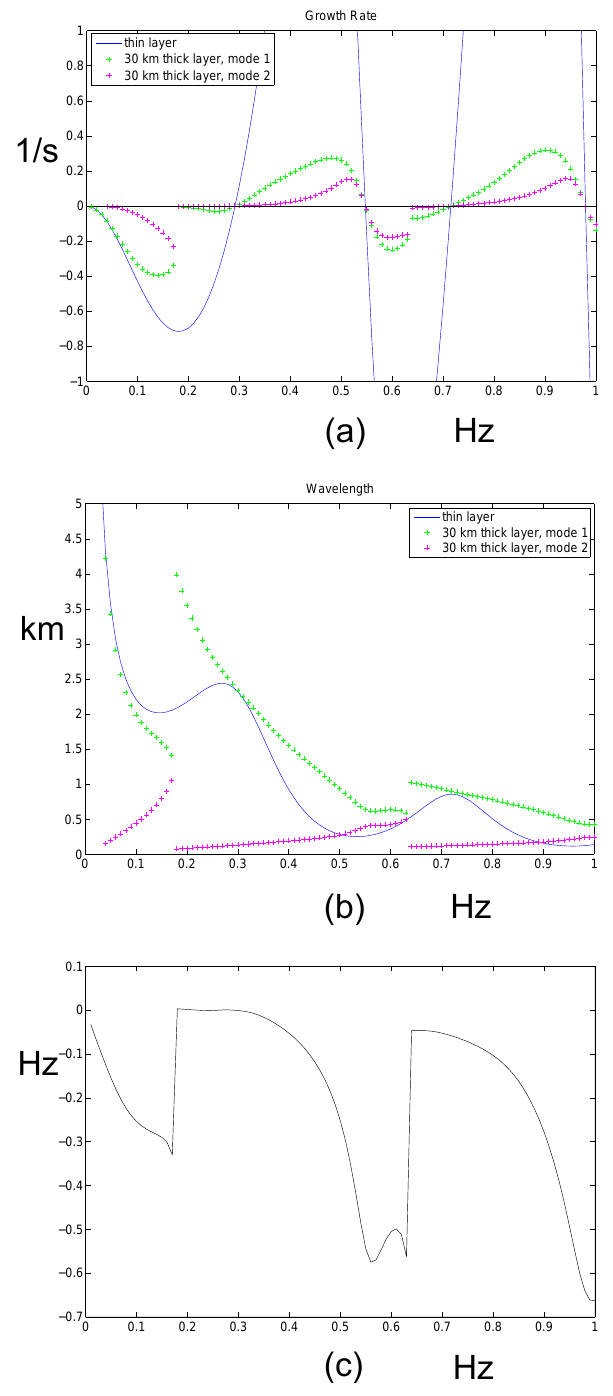
Fig. 8. Same as Figs. 6a through 6c, except for E 0 = 35 mVm − 1 , and with a finer vertical